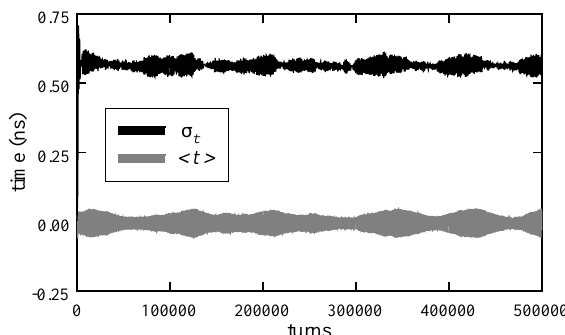
FIG. 6. Simulation of a fast mode-coupling Robinson instabil- ity for passive Landau-cavity operation with the LF20 lattice, for a ring current of 200 mA and Landau-cavity tuning angle of 2 88.08 ±